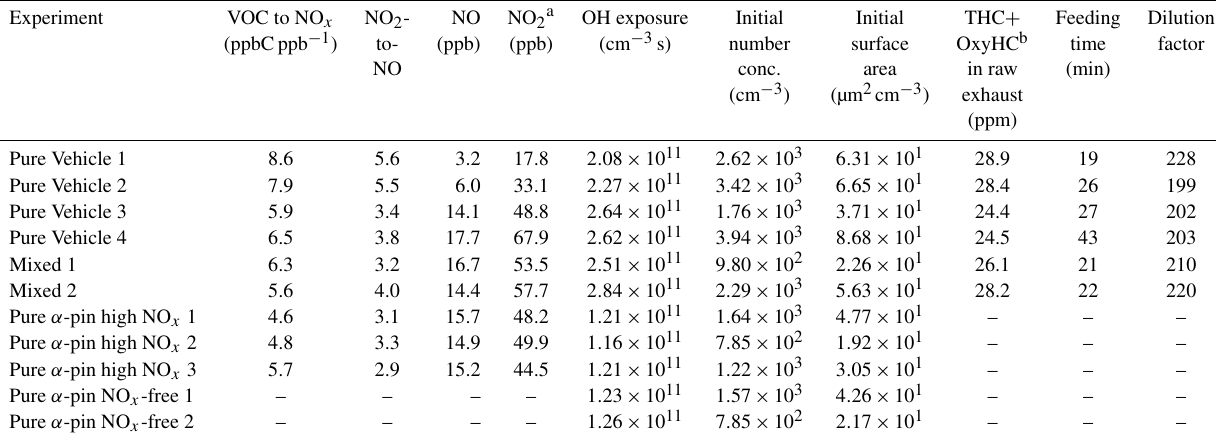
Table 2. Experimental conditions of the experiments conducted in this